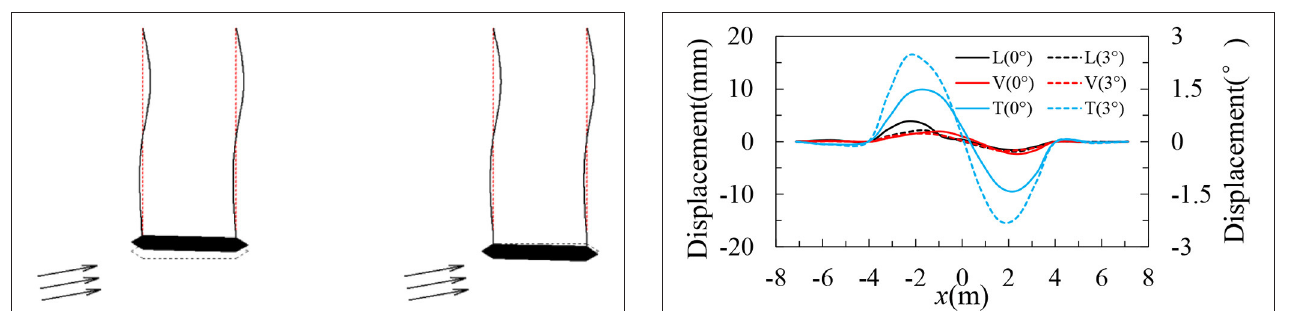
FIGURE 24 | Flutter shapes under uniform